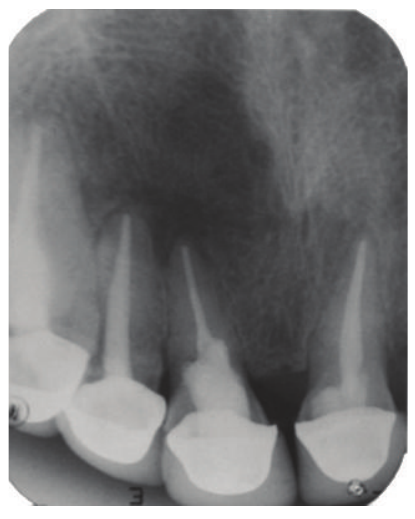
Figure 23: 24-month followup IOPA radiograph.